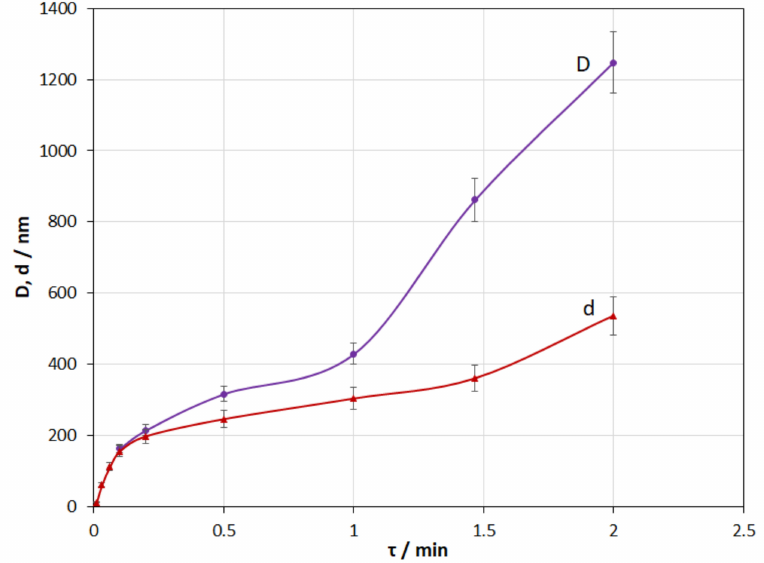
Figure 14. Dependence of the average coating thickness (D) and average particle size (d) on the deposition time ( τ ). in case of decimal